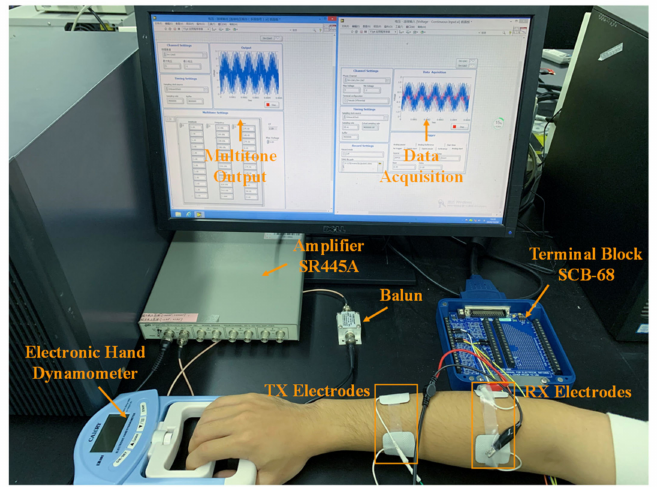
Figure 5. Measurement configuration for measuring motionless and dynamic body channel